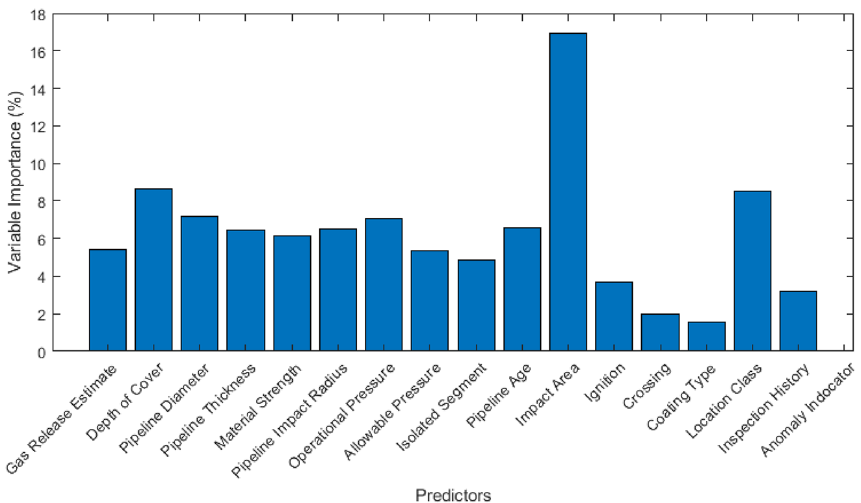
Figure 5. Variable importance of the top features in the study. The results are based on analyzing the deterioration of CART models with respect to removing one of the variables and reporting the relative performance of the model based on all experiments. Notice that the built-in anomaly indicator in the SCADA system (when available) does not provide useful information to the machine learning model, as it is often not